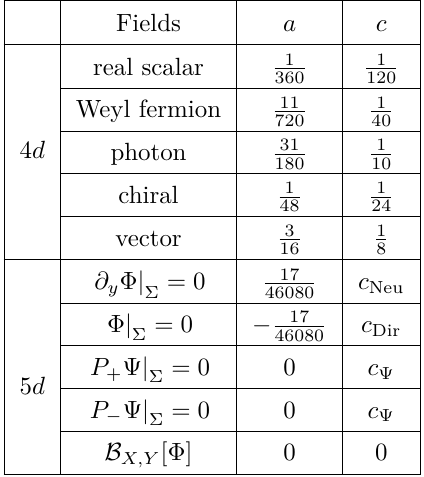
Table 2 . The conformal anomalies of 4d free fields and N = 1 supermultiplets, and the boundary conformal anomalies of 5d free fields and their supersymmetric